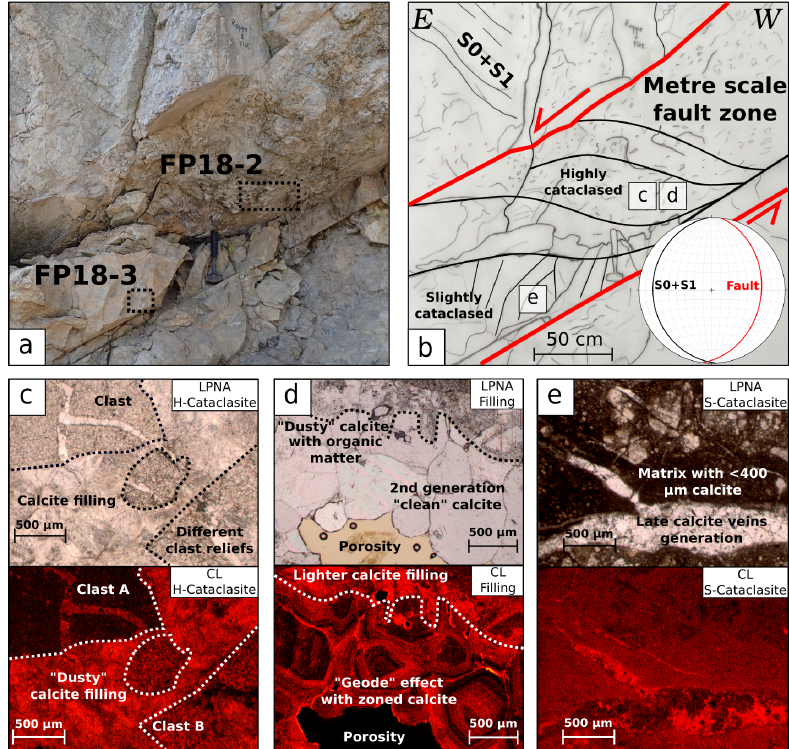
Figure 5. (a–b) Outcrop interpretation of the Tournoux scarp showing various degrees of cataclasis in Triassic dolomitic limestone with Wulff stereogram, lower hemisphere. Squares are sampled area; sample FP18-2 is a highly cataclased sample, while sample FP18-3 is less intensely cataclased and is cross-cut by millimetre-scale calcite veins. (c–e) Microscope and cathodoluminescence pictures showing several calcite filling generations. “Clear calcite” shows zonings and seems to crystallize into a primary porosity left within the cataclasite. The clear calcite and veins from the cataclasite are dated using the method of U–Pb dating on